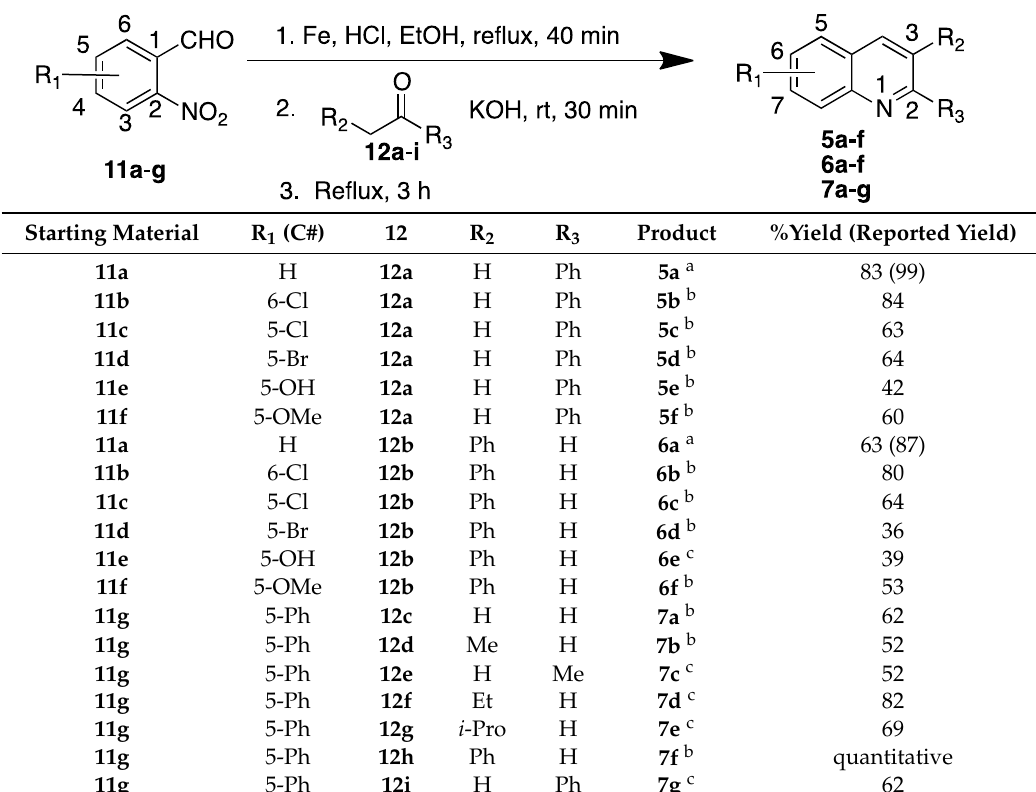
Table 1. Synthesis of substituted quinolines 5a – 5f , 6a – 6f and 7a – 7g .